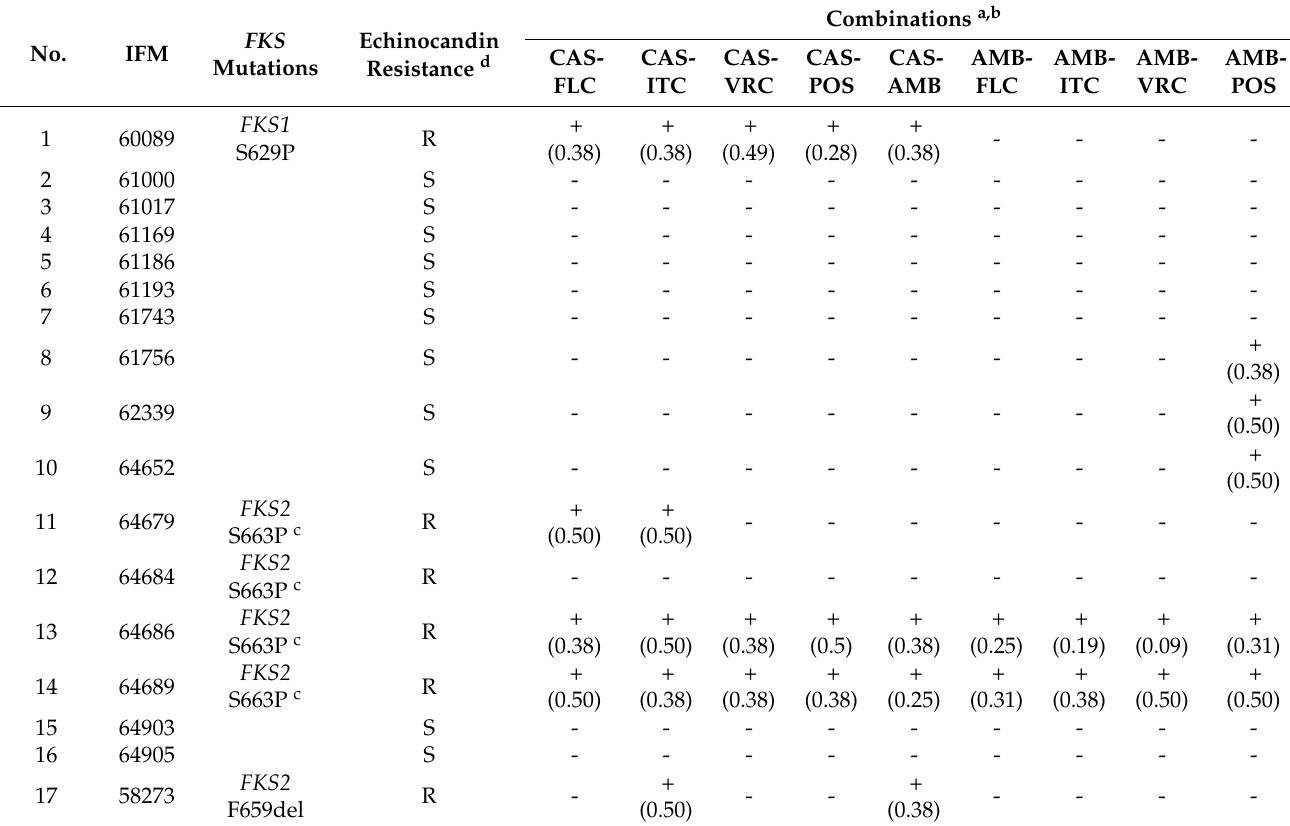
Table 4. Complete characterization of the combinations with synergism.